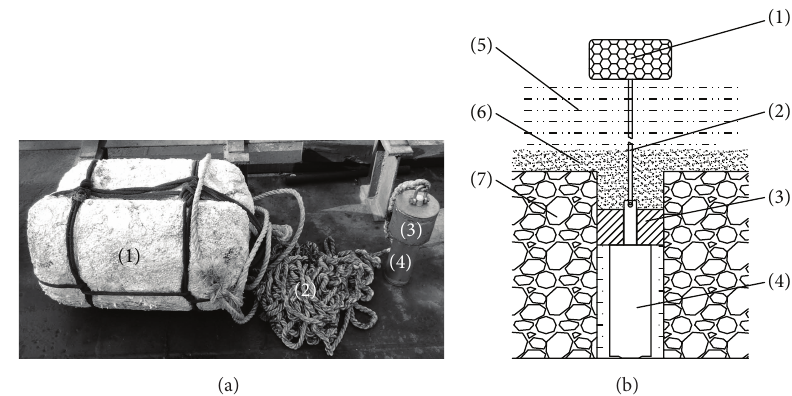
Figure 3: Measuring circumstance diagram.